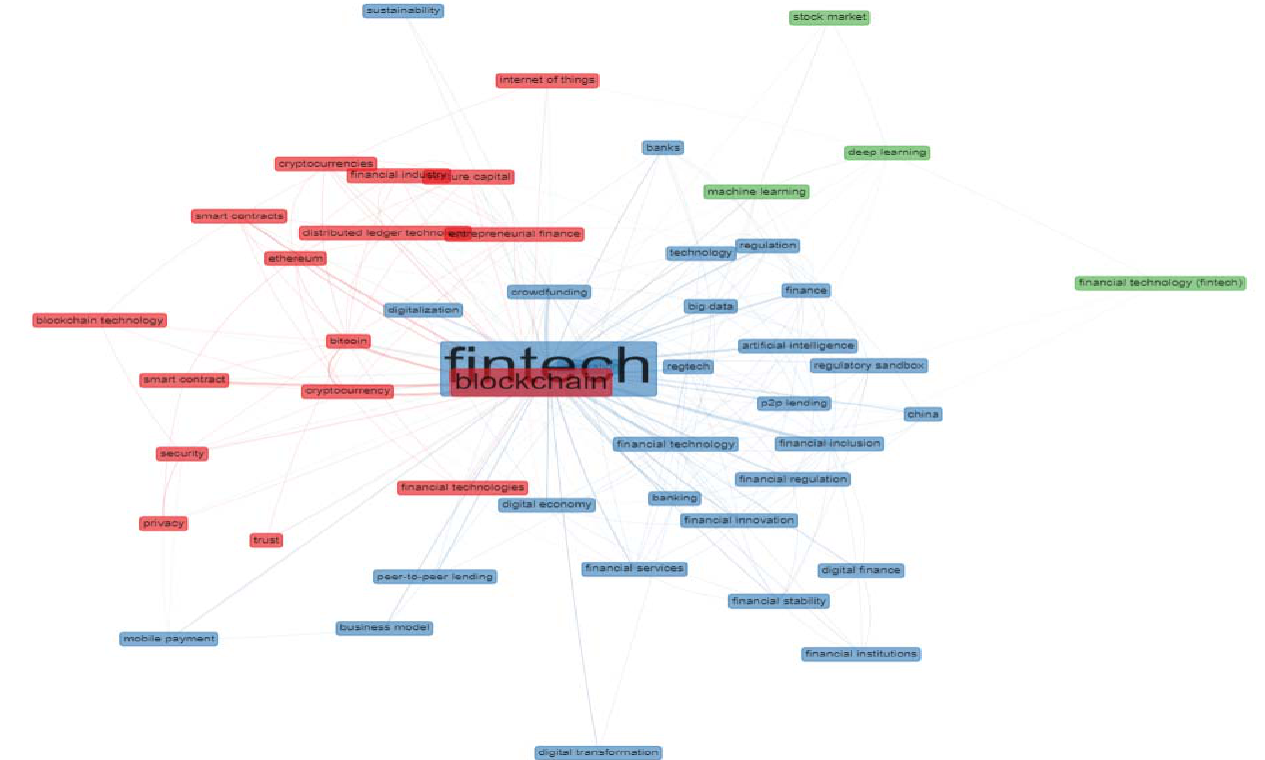
Figure 7. Co-occurrence network.